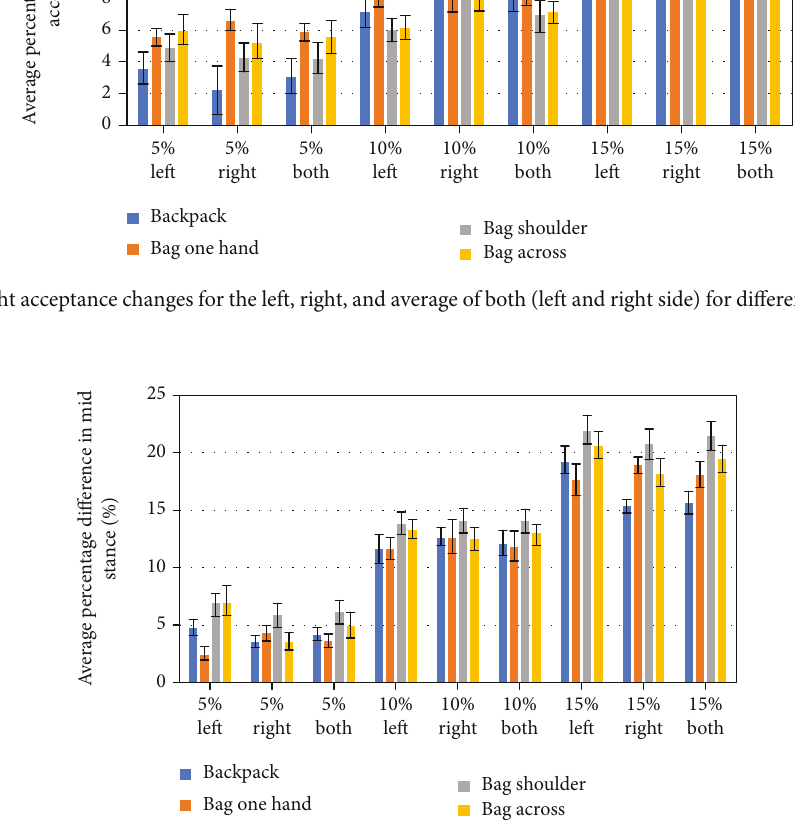
Figure 7: Midstance force changes for the left, right, and average of both (left and right side) for di ff erent levels of additional load.